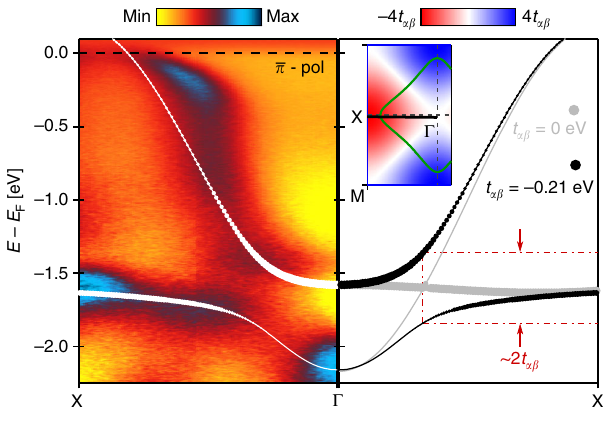
Fig. 3 Avoided band crossing. Left panel: ultraviolet ARPES data recorded along the ant-inodal direction using 160 eV linear horizontal polarised photons. Solid white lines are the same tight-binding model as shown in Fig. 2. Right panel: tight-binding model of the d x 2 (cid:1) y 2 and d z 2 bands along the anti-nodal direction. Grey lines are the model prediction in absence of inter- orbital hopping ( t αβ = 0) between d x 2 (cid:1) y 2 and d z 2 . In this case, the bands are crossing near the Γ -point. This degeneracy is lifted once a fi nite inter-orbital hopping parameter is considered. For solid black lines t αβ = − 210 meV and other hopping parameters have been adjusted accordingly. Inset indicates the Fermi surface (green line) and the Γ − X cut directions. Coloured background displays the amplitude of the hybridisation term Ψ ( k ) that vanishes on the nodal